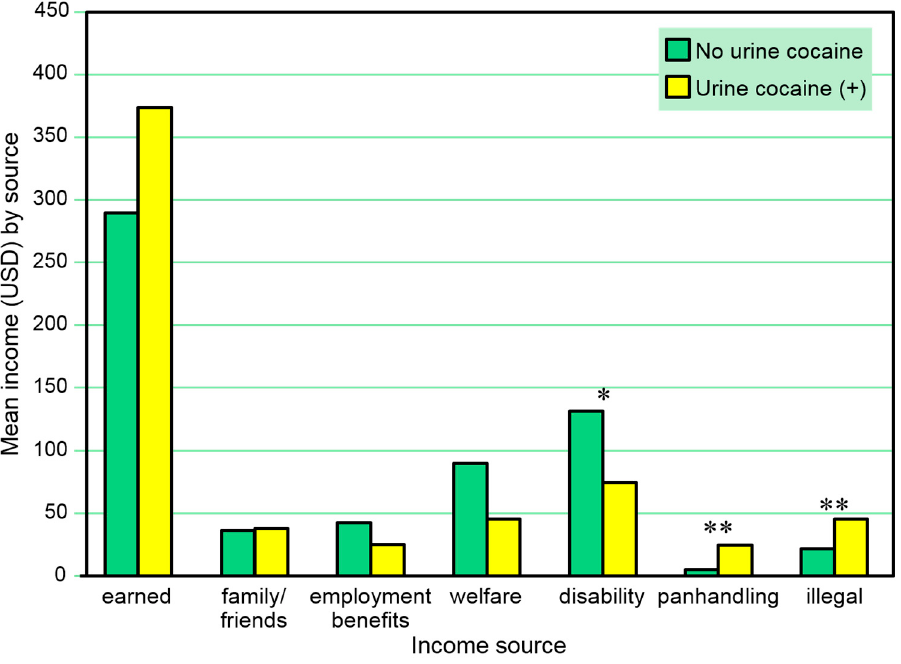
Figure 3. Total amounts earned from 30-day income sources across three interviews among those with and without a positive urine cocaine test at any time point. * p ≤ 0.05, ** p ≤ 0.01.